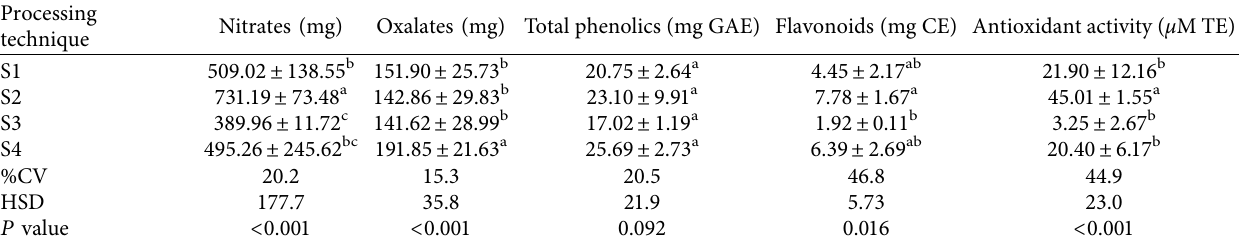
Table 3: Antinutrient content and antioxidant activity of traditional preserved cowpea leaves (mg/100 g dry matter basis).